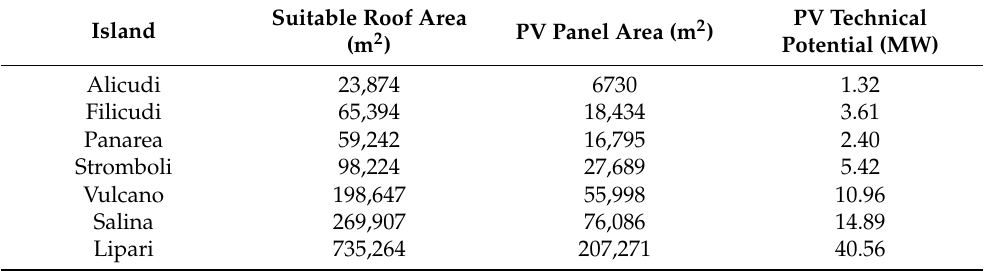
Table 8. Eolian PV technical potential on rooftops.